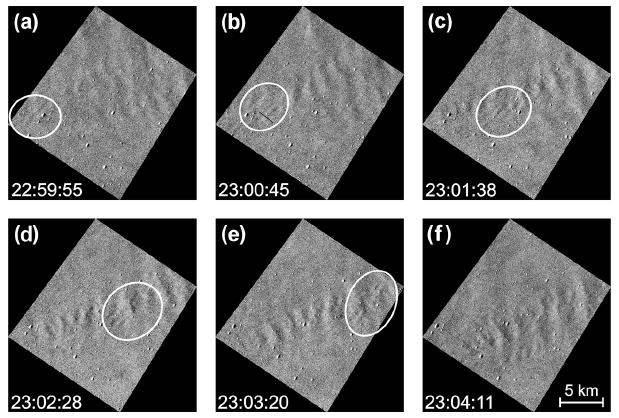
Figure 2. Image series of the case study of 18 November 2015 be- tween 22:59:55 and 23:04:11UTC. Difference images have been chosen for presentation purposes. The images are aligned to the north. The 1.7km wave structure extends from the western to the eastern corner with several crests being arranged in a narrow cor- ridor. The 550m wave packet is framed in a white ellipse ( a – e ). One may perceive the beginning decay at 23:03:20UTC. The entire sequence is shown in Video 1 of the Supplement. The black line, which is shown in (b) , indicates the cross section along which the spectral analysis is performed in Figs. 3 and